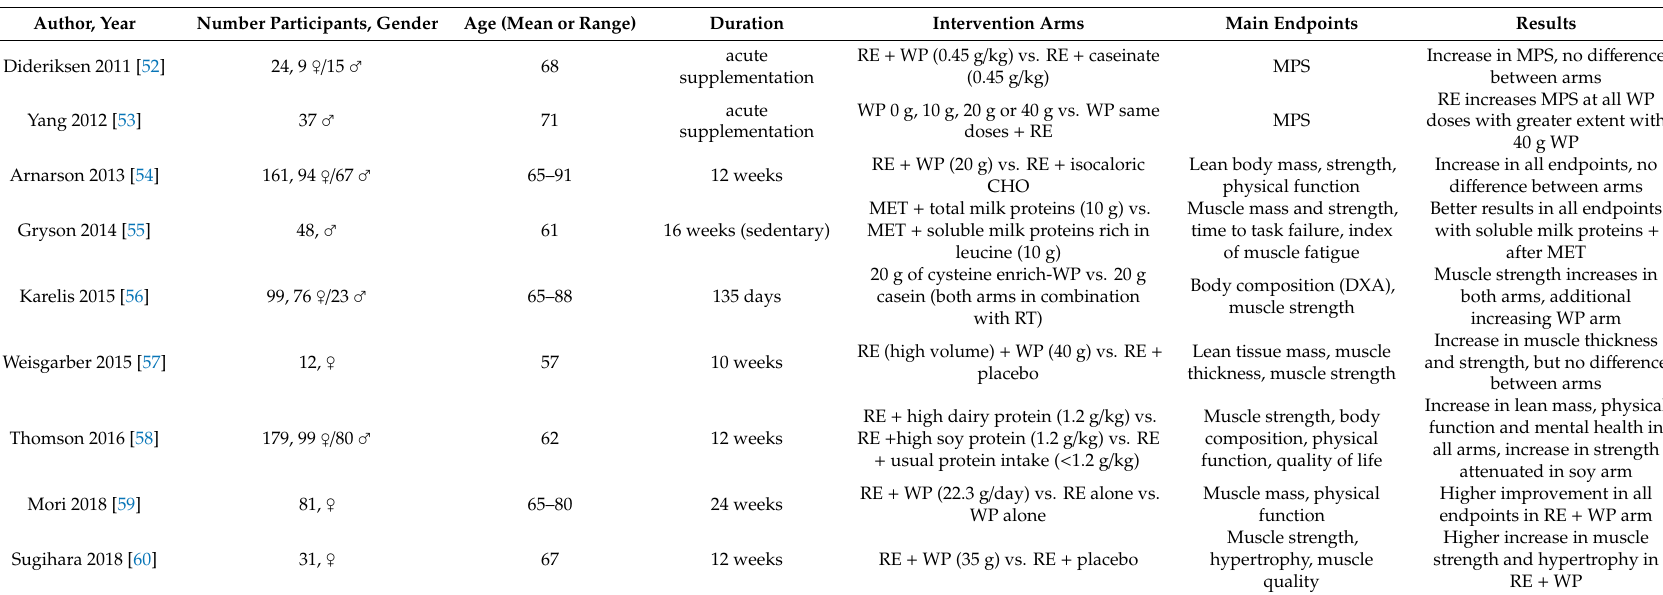
Table 2. Randomized Clinical Trials testing the e ff ects of di ff erent protein supplementation in combination with exercise